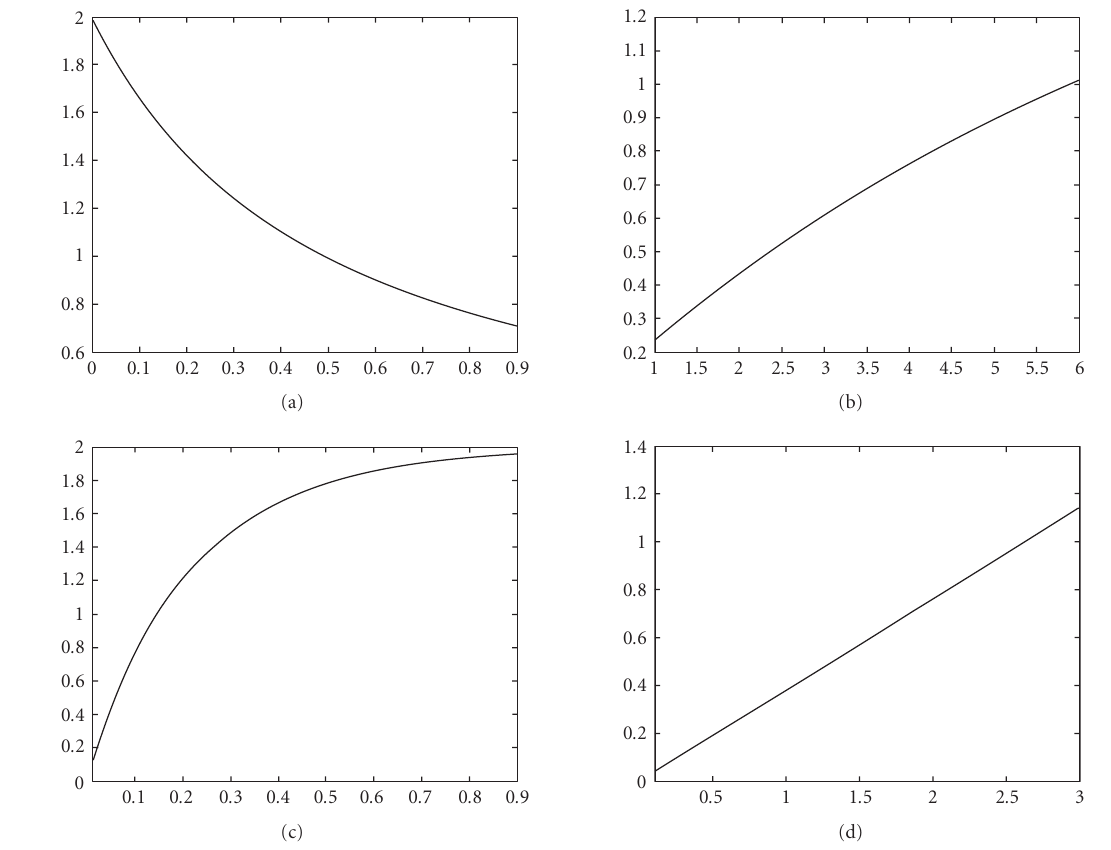
Figure 1: The relationship between the parameters and R ∗ : (a) “ θ − R ∗ ,” (b) “ τ − R ∗ ,” (c) “ μ − R ∗ ,” (d) “ R 0 − R ∗